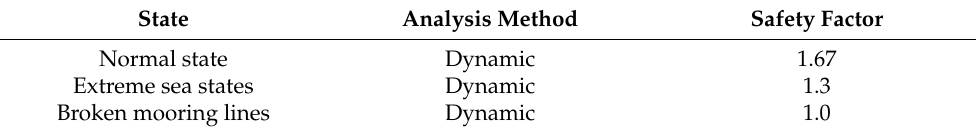
Table 4. Requirements of the minimum safety factors. State Analysis Method Normal state Extreme sea states Broken mooring lines